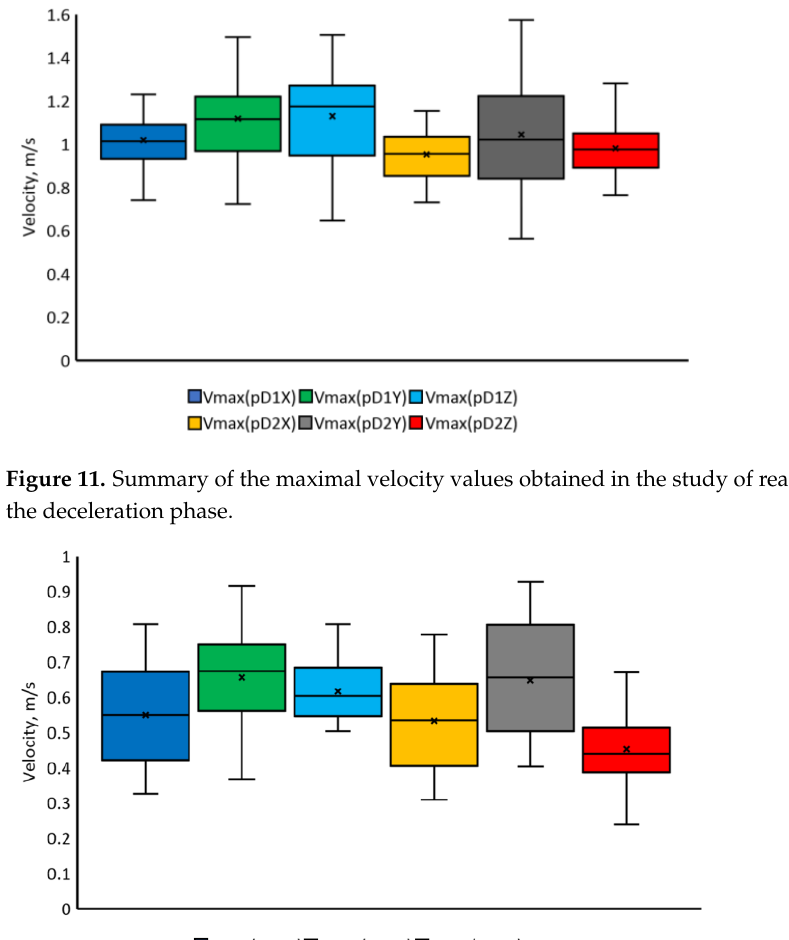
Figure 12. Summary of RMS velocity values obtained in the study of reaching movements in the deceleration phase.